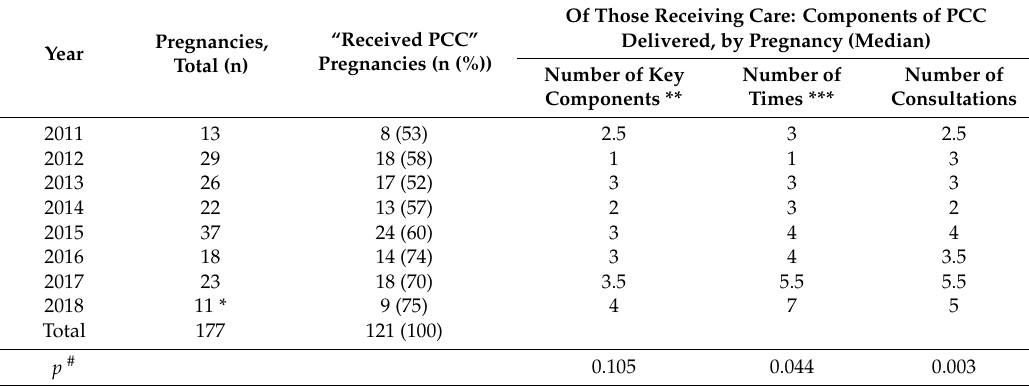
Table 3. Preconception care (PCC) over